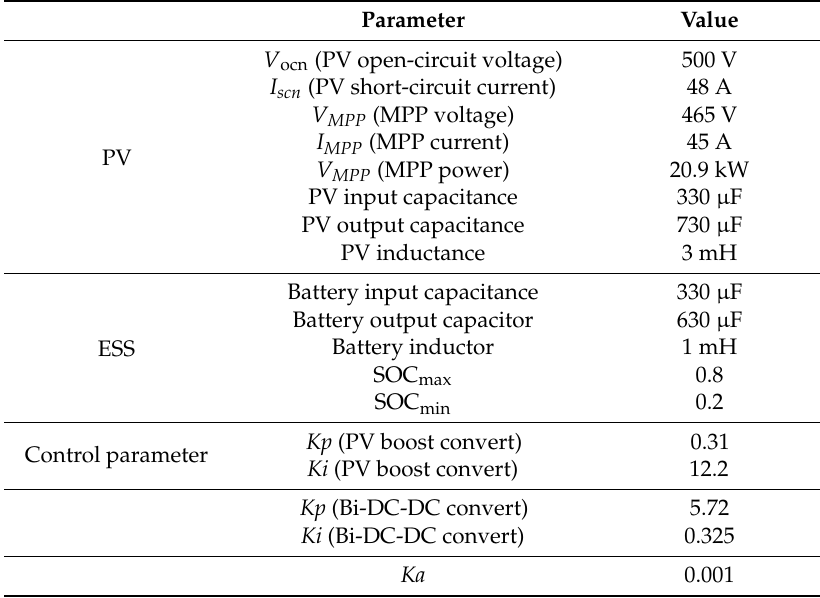
Table 1. Parameters of the PV modules and ESS used in simulation.